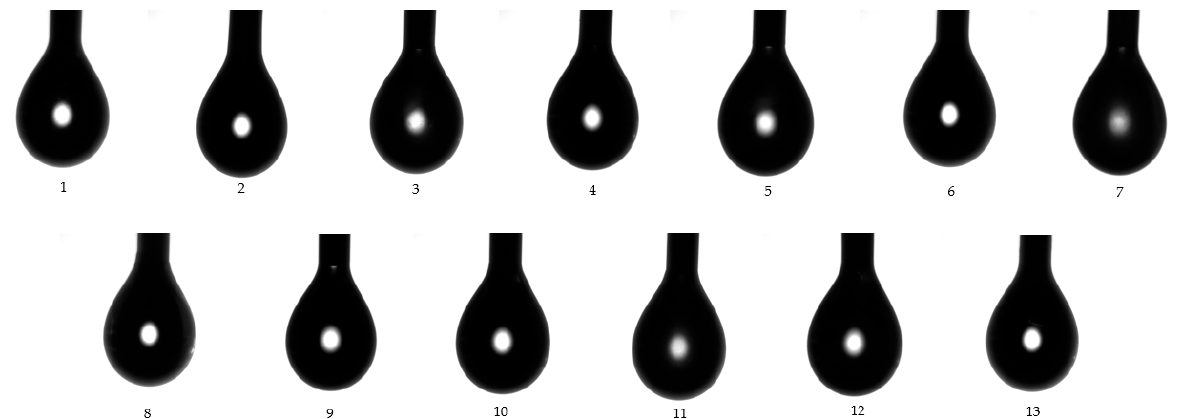
Figure 8. Captures for microemulsion drops (1–13) in pendant drop model study, evaluating γ LG at 25 ± 0.5 °C.